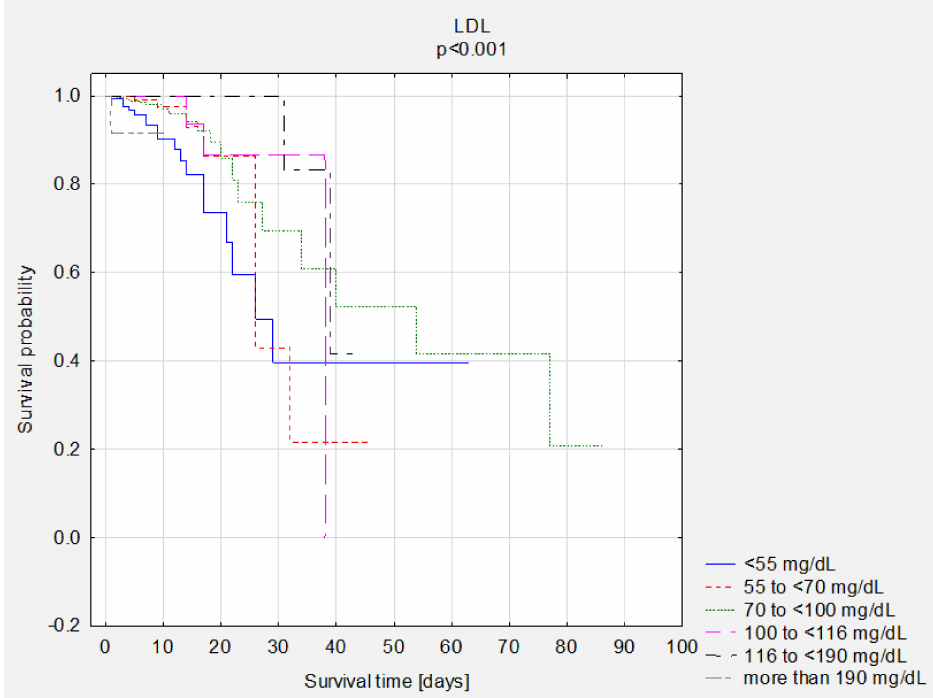
Figure 4. The comparison of survival curves according to LDL scores. Abbreviations: LDL, low- density